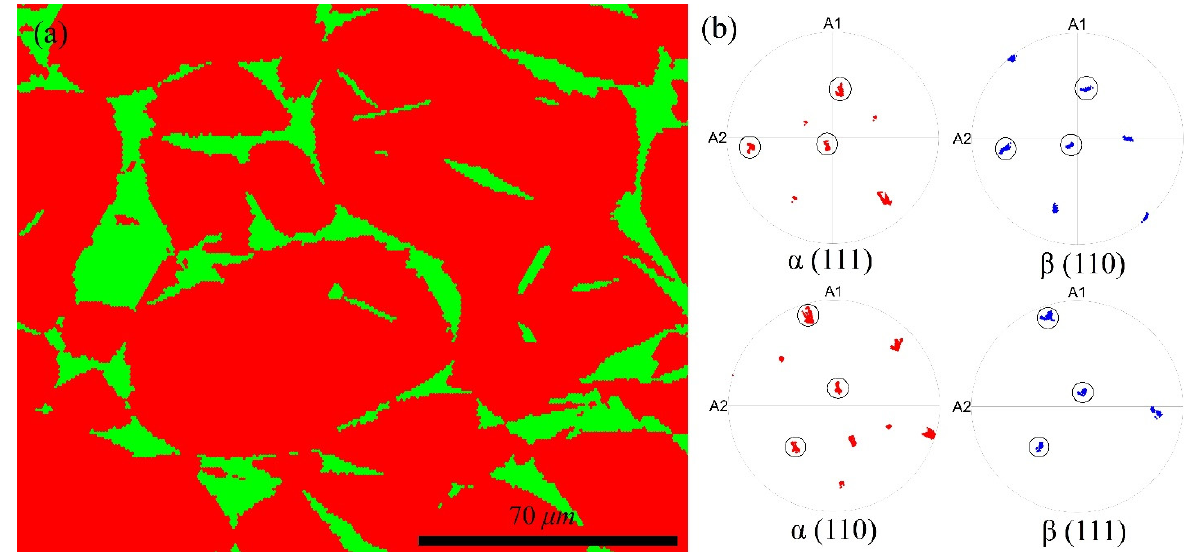
Figure 5. ( a ) Phase map of the double-phase sample at higher magnification. ( b ) (110) and (111) pole figures of α and β (formed at α primary grain boundaries) phases near the interfacial areas.